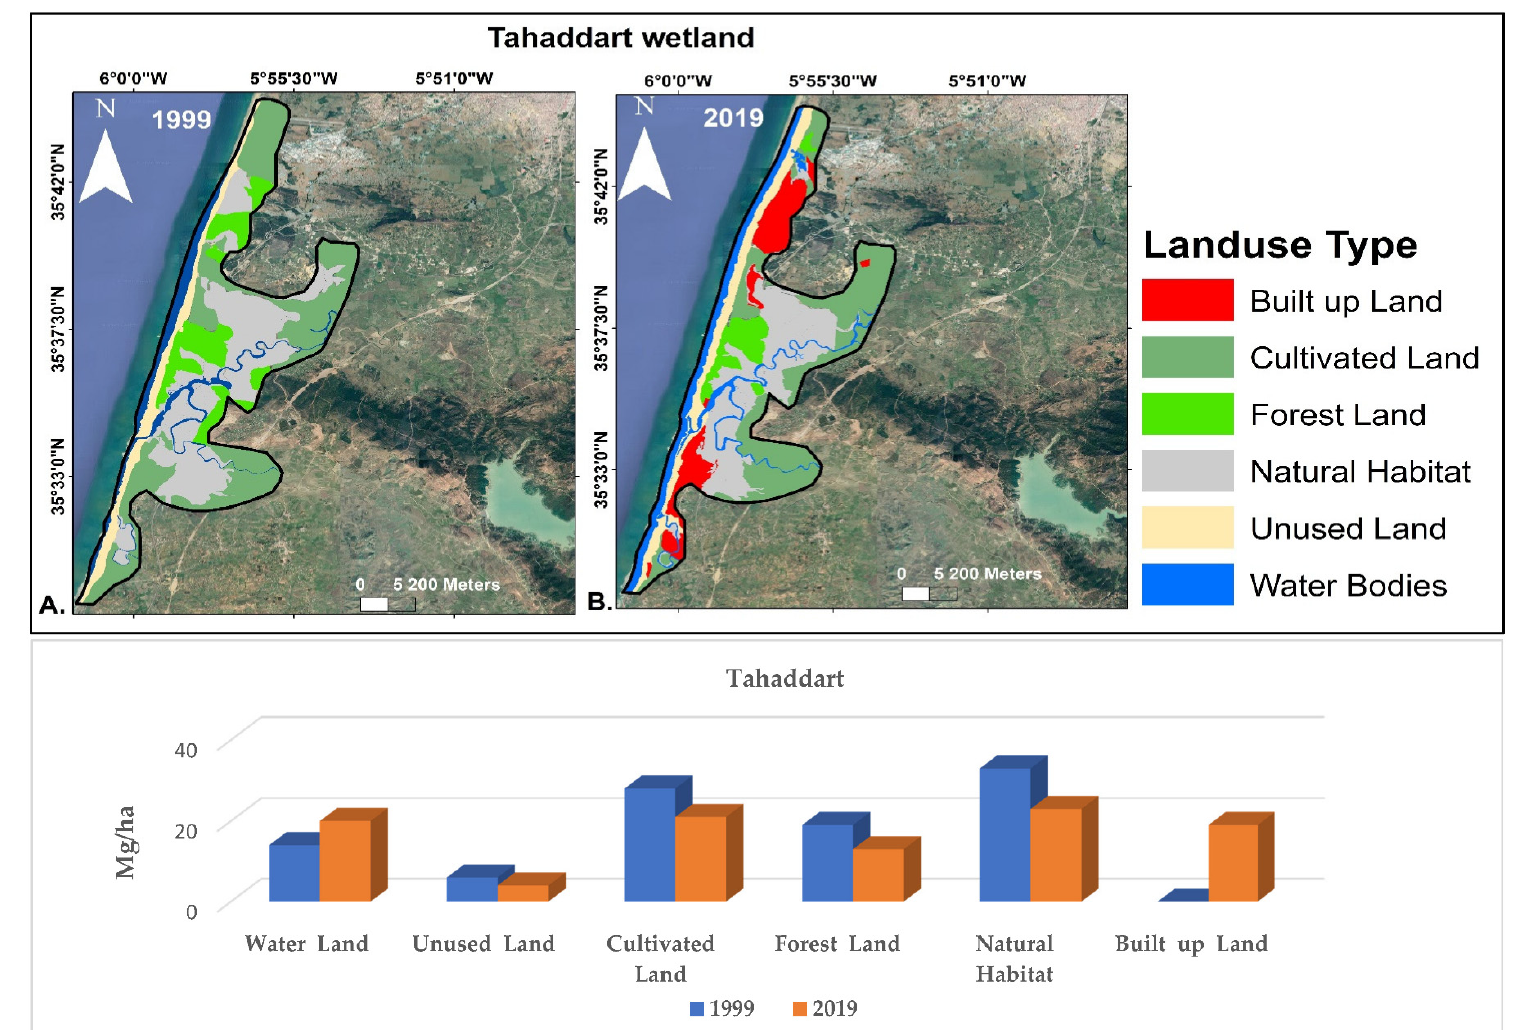
Figure 4. Maps and percentages of LULC changes in Tahaddart between 1999 and 2019: ( A ) LULC change of 1999; ( B ) LULC change of 2019 .